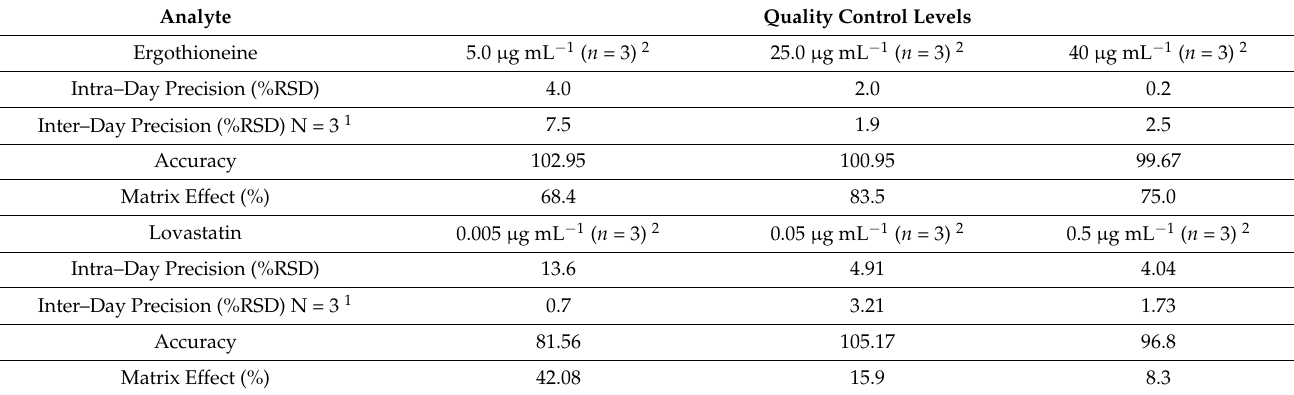
Table 2. Precision, accuracy, and matrix effect of LC–MS method of ergothioneine and lovastatin. Analyte